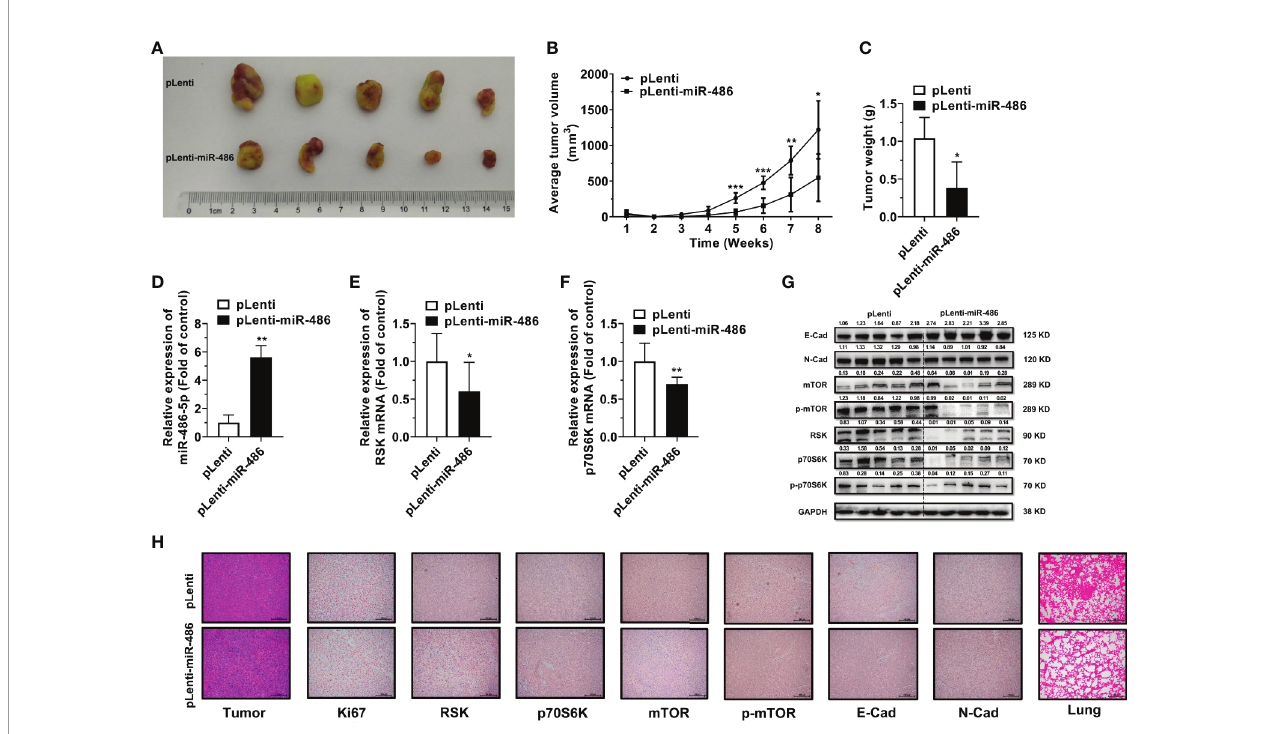
FIGURE 6 | miR-486-5p inhibits tumor growth and metastasis in vivo . (A) The xenografts images of H1299 cells transfected with pLenti or pLenti-miR-486. (B) The growth curve of xenografts from one-week post-injection until sacri fi ce at week 8. *p < 0.05; **p < 0.01; ***p < 0.001. (C) The tumor weight of xenografts at week 8. *p < 0.05. (D – F) The RNA expression of miR-486-5p (D) , RSK (E) and p70S6K (F) in pLenti-miR-486 transfected xenografts compared with pLenti transfected ones. *p < 0.05; **p < 0.01. (G) The protein expression of E-Cad, N-Cad, mTOR, p-mTOR, RSK, p70S6K and p-p70S6K in xenografts.